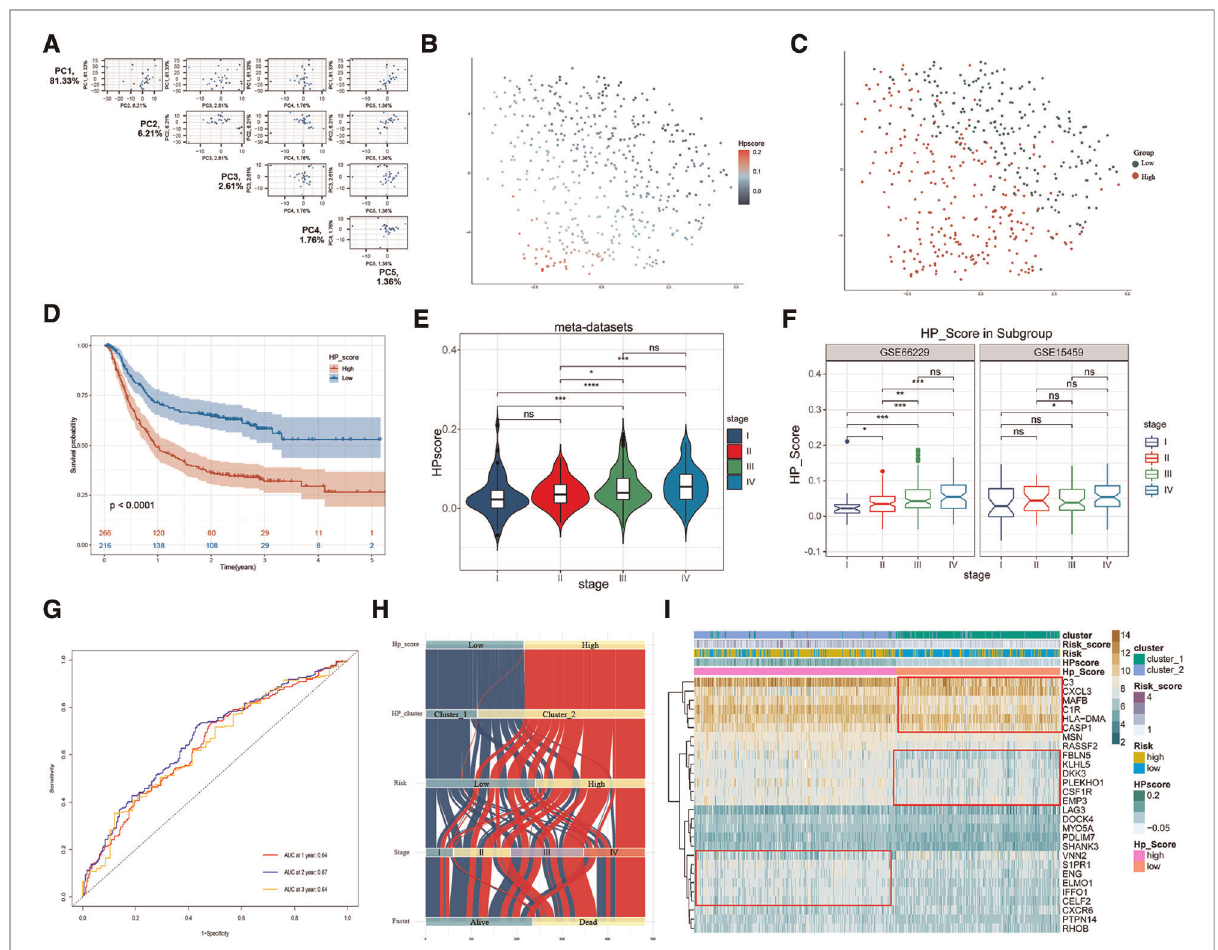
FIGURE 5 Construction of HPscore system and veri fi cation of system stability. ( A ) Pairs plot showing the results of principal component analysis (PCA) base on 28 HP-related prognostic genes. ( B,C ) The T-SNE of HPscore and Hp_Score groups for all samples. ( D ) Overall survival analysis veri fi ed HPscore system in meta-dataset. ( E,F ) The differences of HPscore in gastric cancer stages were observed in the meta-dataset and internal datasets, respectively. ( G ) ROC curves for 1-year, 2-year and 3-year overall survival, with AUC=0.64, 0.67 and 0.64 respectively. ( H ) The Sankey map of samples in HP_score group, risk group, clusters group, stages, and survival outcome. ( I ) Heatmap of the expression levels of 28 HP-related prognostic genes in different